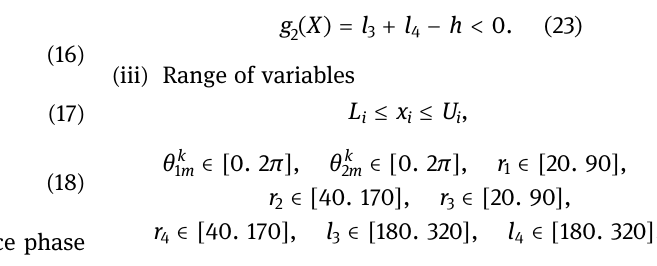
Figure 4: Comparison of swing phase foot trajectory.